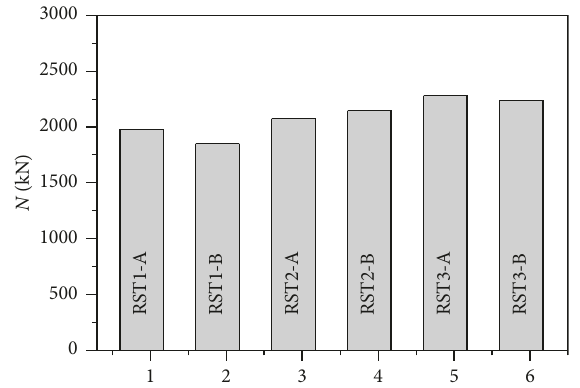
Figure 5: Comparison of specimen